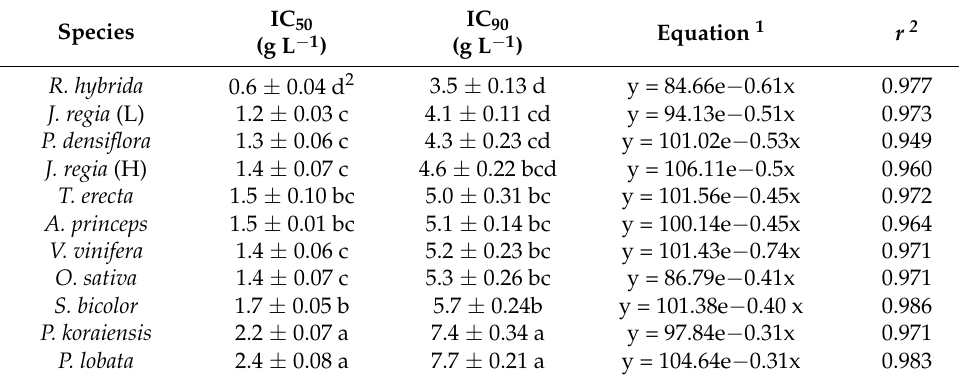
Table 2. IC 50 and IC 90 of allelopathic extracts effect on algal